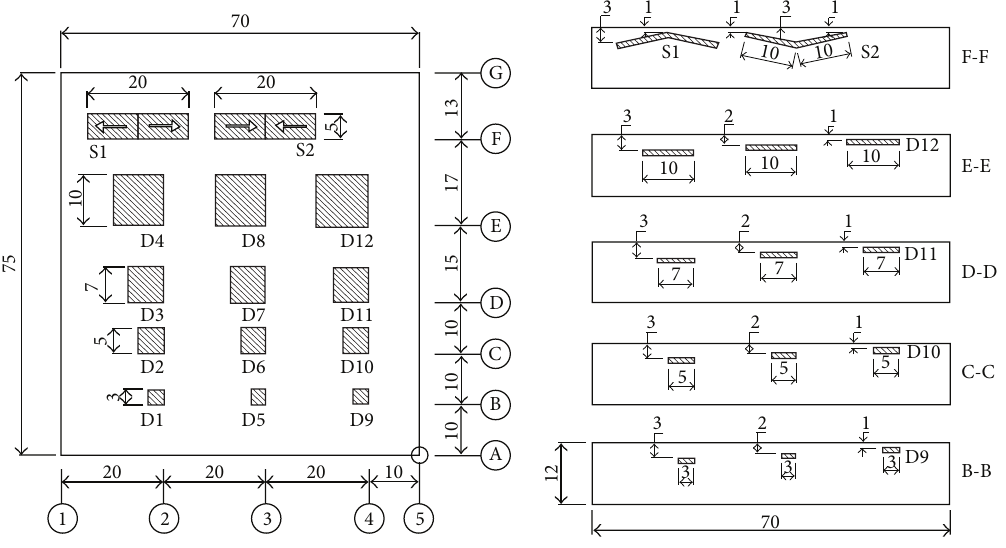
Figure 3: Concrete specimen.